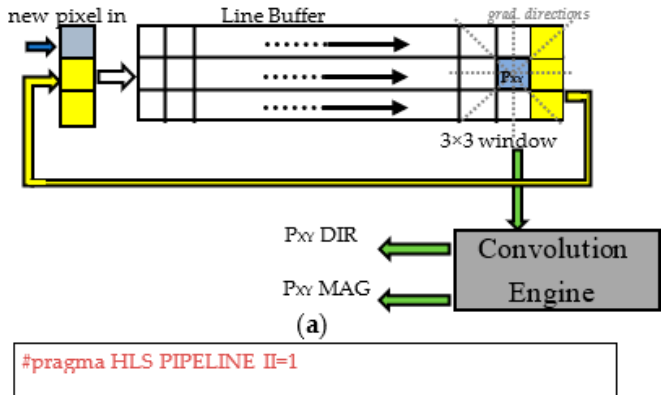
Figure 14. Excerpt of the C++ HLS description of the non-maximum suppression module. Once the output image of the Canny edge detection module is stored back into the external DDR memory, the software routine running on the PS performs the contour selection computational step. At this time, the elaborated image is segmented, as shown in Figure 3c. Then, the DMA 1 is programmed and activated and the segmented image is